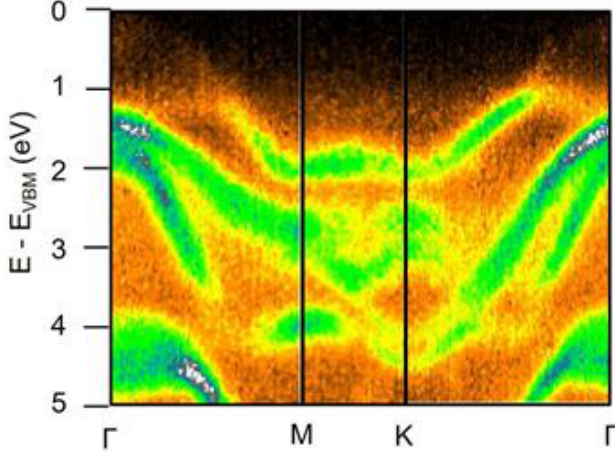
Figure 3. Experimental band structure of β-InSe along the high-symmetry directions. The energy scale was set to zero at valence-band maximum (VBM). Reproduced with permission from Ref. [68]. The orbital components of the different bands experimentally revealed by ARPES are indicated by projections to 5p (panel a of Figure 4) and 5s (panel b) states of In and to 4p (panel c) and 4s (panel d) states of Se along the whole Brillouin zone.